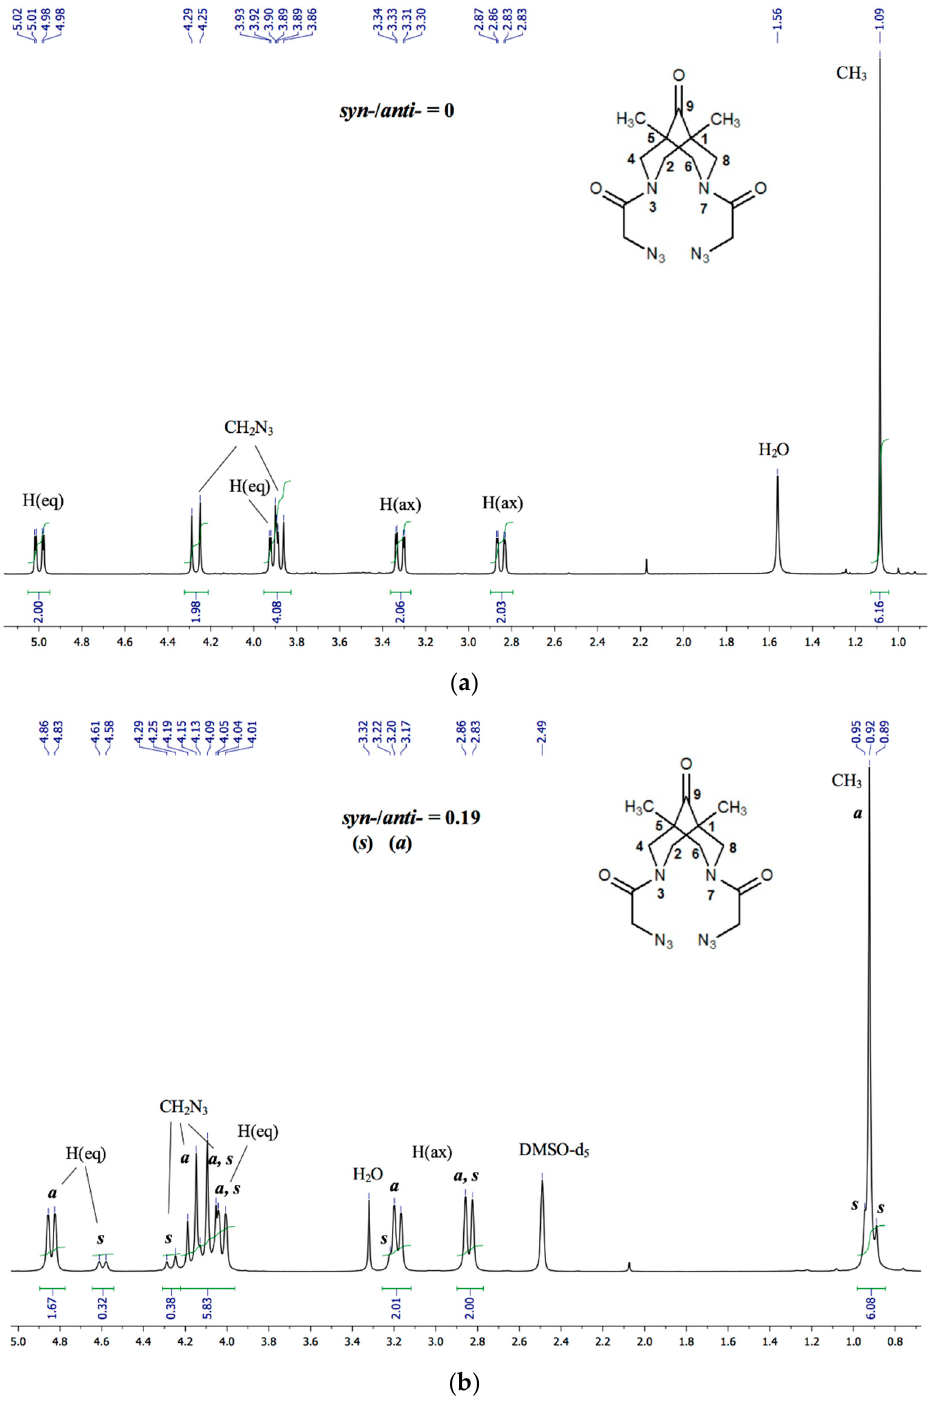
Figure 3. 1 H NMR spectrum of 1e in CDCl 3 ( a ); 1 H-NMR spectrum of 1e in DMSO- d 6 ( b ).